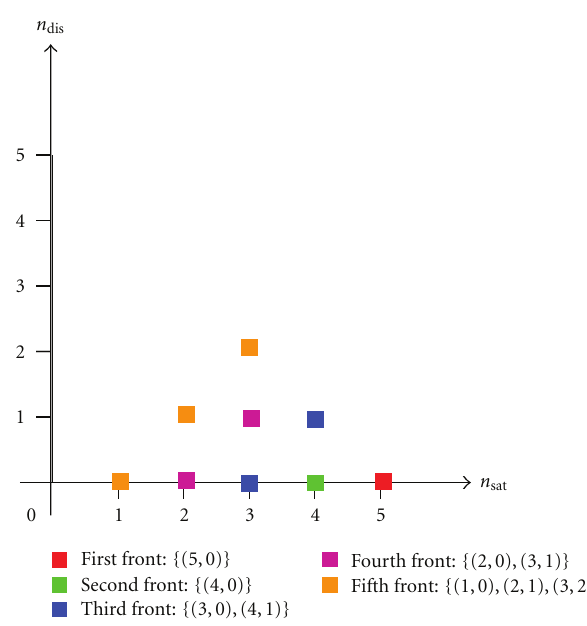
F 4: Several NSGA-II ’s nondominated fronts of problem (5).